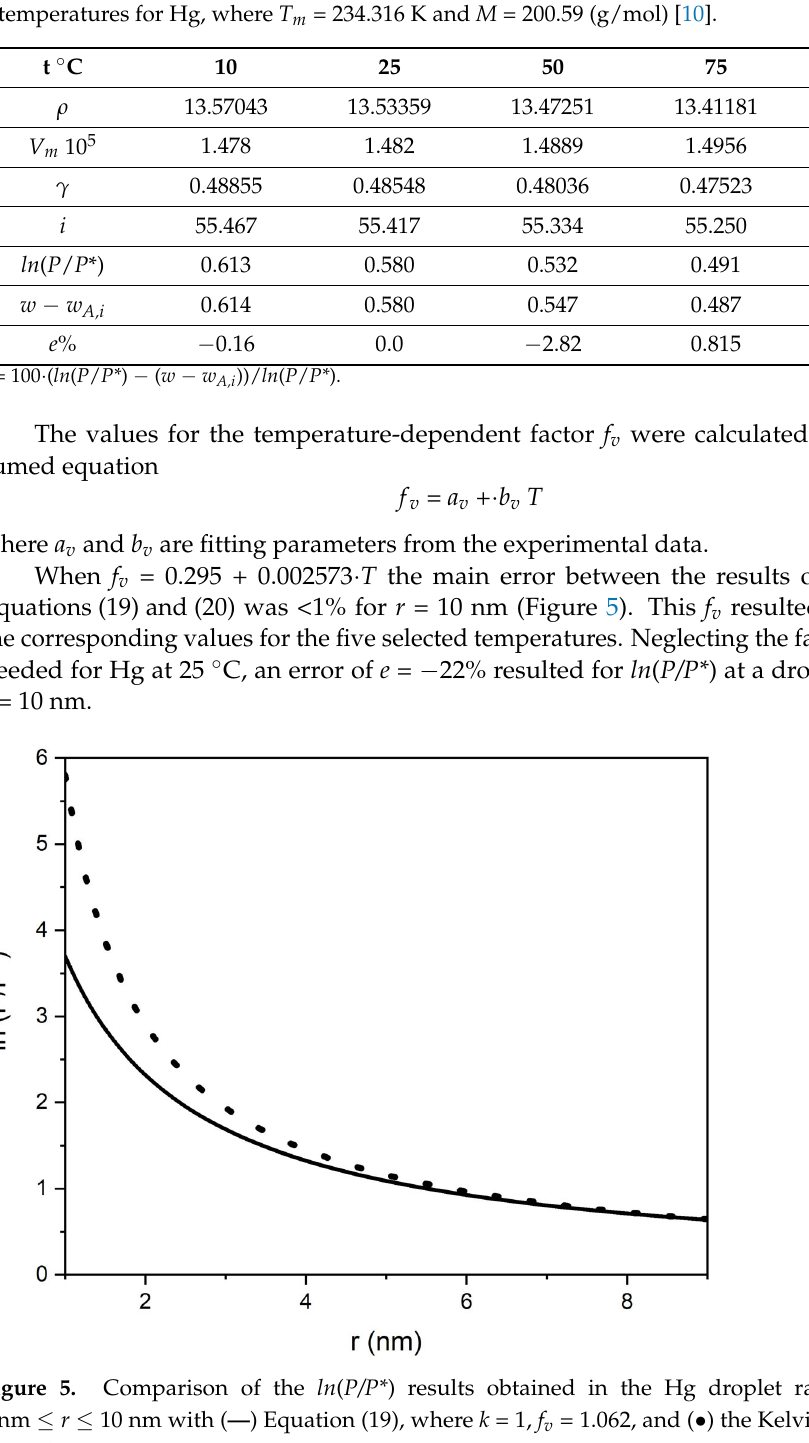
Figure 5. Comparison of the ln ( P/P* ) results obtained in the Hg droplet radius range of 1 nm ≤ r ≤ 10 nm with ( ▬ ) Equa ‐ tion (19), where k = 1, f v = 1.062, and ( ● ) the Kelvin Equation (20) atö 25